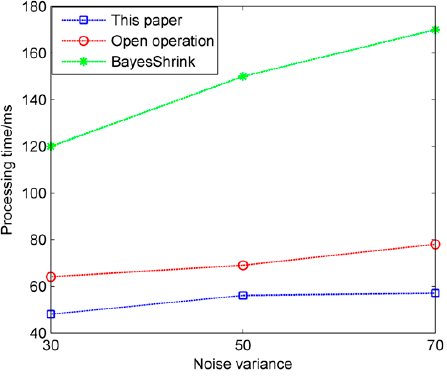
Figure 11. Processing time of denoising algorithms.